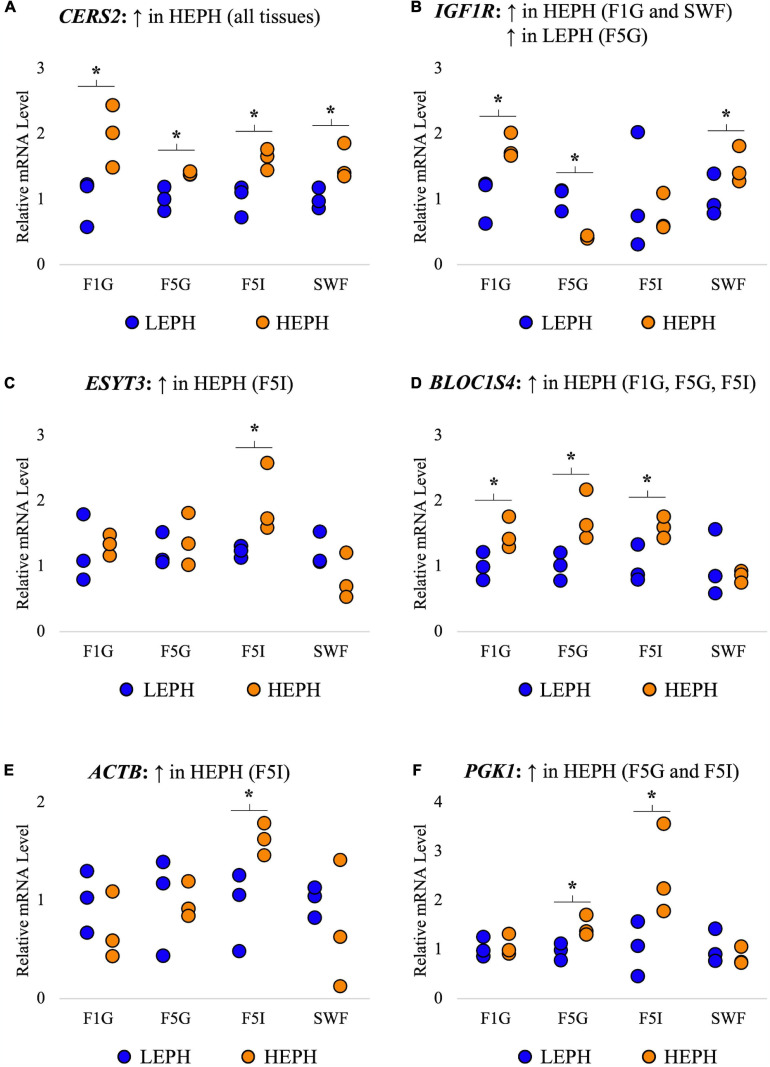
Confirmation of RNAseq gene expression results. Confirmation of RNA sequencing results in the F1 granulosa (F1G), F5 granulosa (F5G), F5 theca interna (F5I), and small white follicles (SWF). A total of 6 genes common to all four tissues that displayed high expression and different expression patterns among the four tissues were selected for confirmation in each tissue through RT-qPCR. The expression differences (P < 0.05) between low egg producing hens (LEPH) and high egg producing hens (HEPH) for each gene seen in RNA sequencing results are listed above each graph. Normalized data are presented relative to LEPH expression for each follicle type for each gene. Significant expression differences between LEPH and HEPH for a given follicle type are denoted with an asterisk (*). (A) Relative mRNA levels for ceramide synthase 2 (CERS2), which was up-regulated in HEPH in all four tissues in RNA sequencing results. (B) Relative mRNA levels for insulin-like growth factor 1 receptor (IGFR1), which showed increased expression in HEPH in the F1G and SWF and increased expression in LEPH in the F5G in RNA sequencing results. (C) Relative mRNA levels for extended synaptotagmin 3 (ESYT3), which was up-regulated in HEPH in the F5I in RNA sequencing results (D) Relative mRNA levels for biogenesis of lysosomal organelles complex 1 subunit 4 (BLOC1S4), which showed increased expression in HEPH in the F1G, F5G, and F5I in RNA sequencing results. (E) Relative mRNA levels for beta-actin (ACTB), which showed up-regulation in HEPH in the F5I in RNA sequencing results. (F) Relative mRNA levels for phosphoglycerate kinase 1 (PGK1), which showed up-regulation in HEPH in the F5G and F5I in RNA sequencing results.